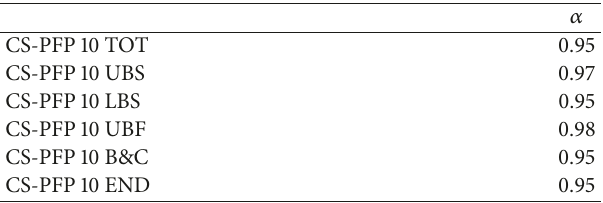
Table 5: Cronbach’s